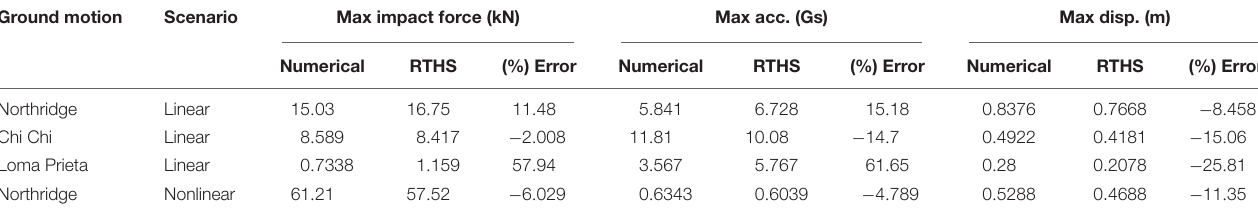
TABLE 3 | Summary of structural response for time history analyses. Ground